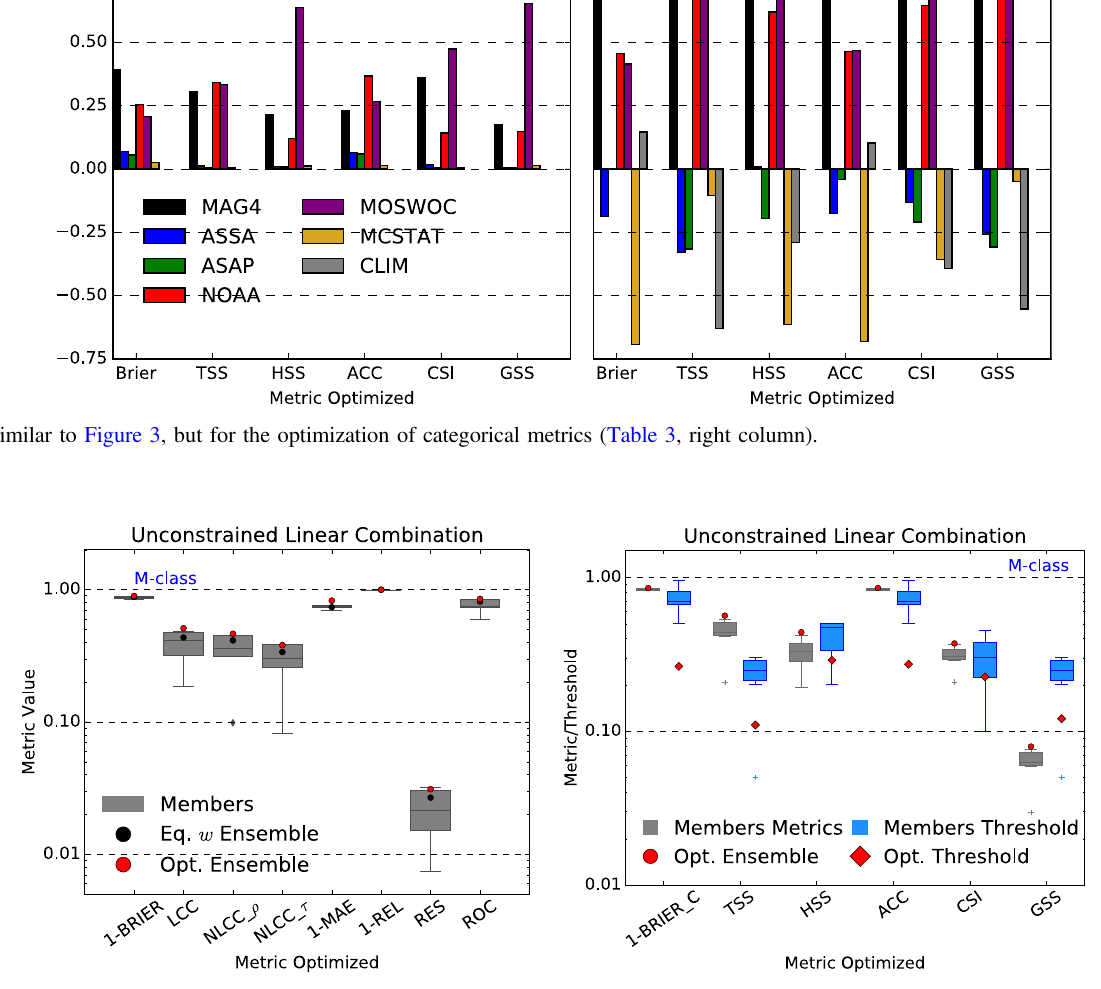
Fig. 5. Left: For probabilistic metrics three values are shown per metric: (1) metrics values for ensemble members are displayed as box-and- whiskers; (2) the metric of the equal-weights ensemble (black circle); (3) the optimized (or best performing) ensemble (red circle). Right: metric and threshold values for categorical-metric ensembles. Gray and blue box-and-whiskers plots correspond to the ensemble members ’ metrics and thresholds. Red circles and diamonds correspond to the optimized-ensemble metrics and thresholds. For better comparison, metrics in both panels that require minimization (i.e., BRIER, MAE, and REL) are displayed as 1 (cid:2) (metric value).